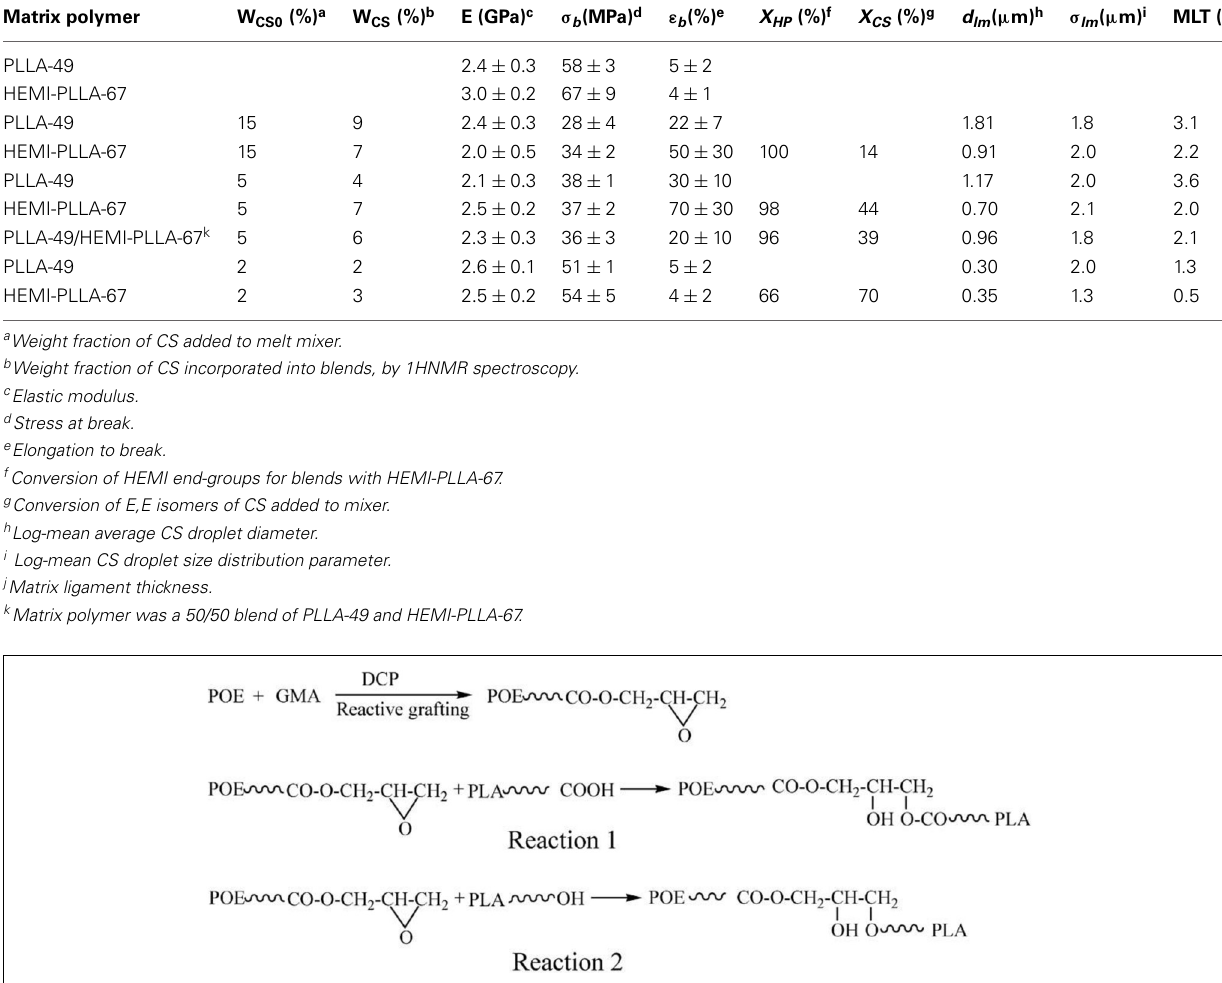
Table 16 | Physical properties of melt blends of CS with PLLA-49 and HEMI-PLLA-67 (Adapted with permission from Gramlich et al.